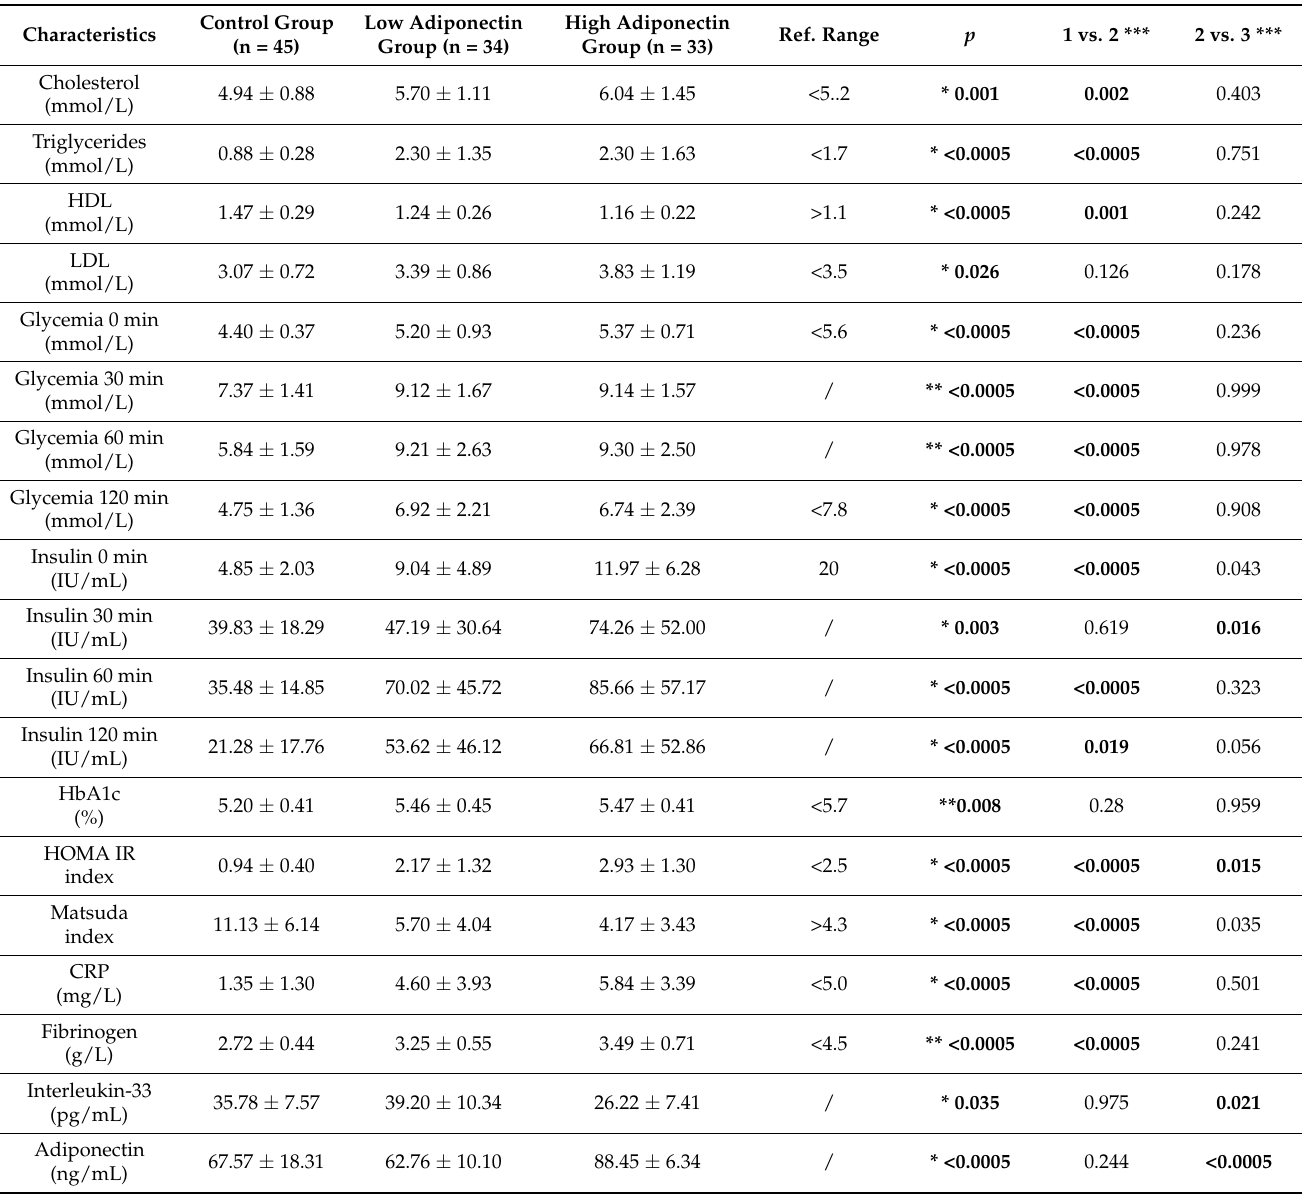
Table 4. Laboratory characteristics of subgroups of patients with MS divided by mean adiponectin (cut off 80.0